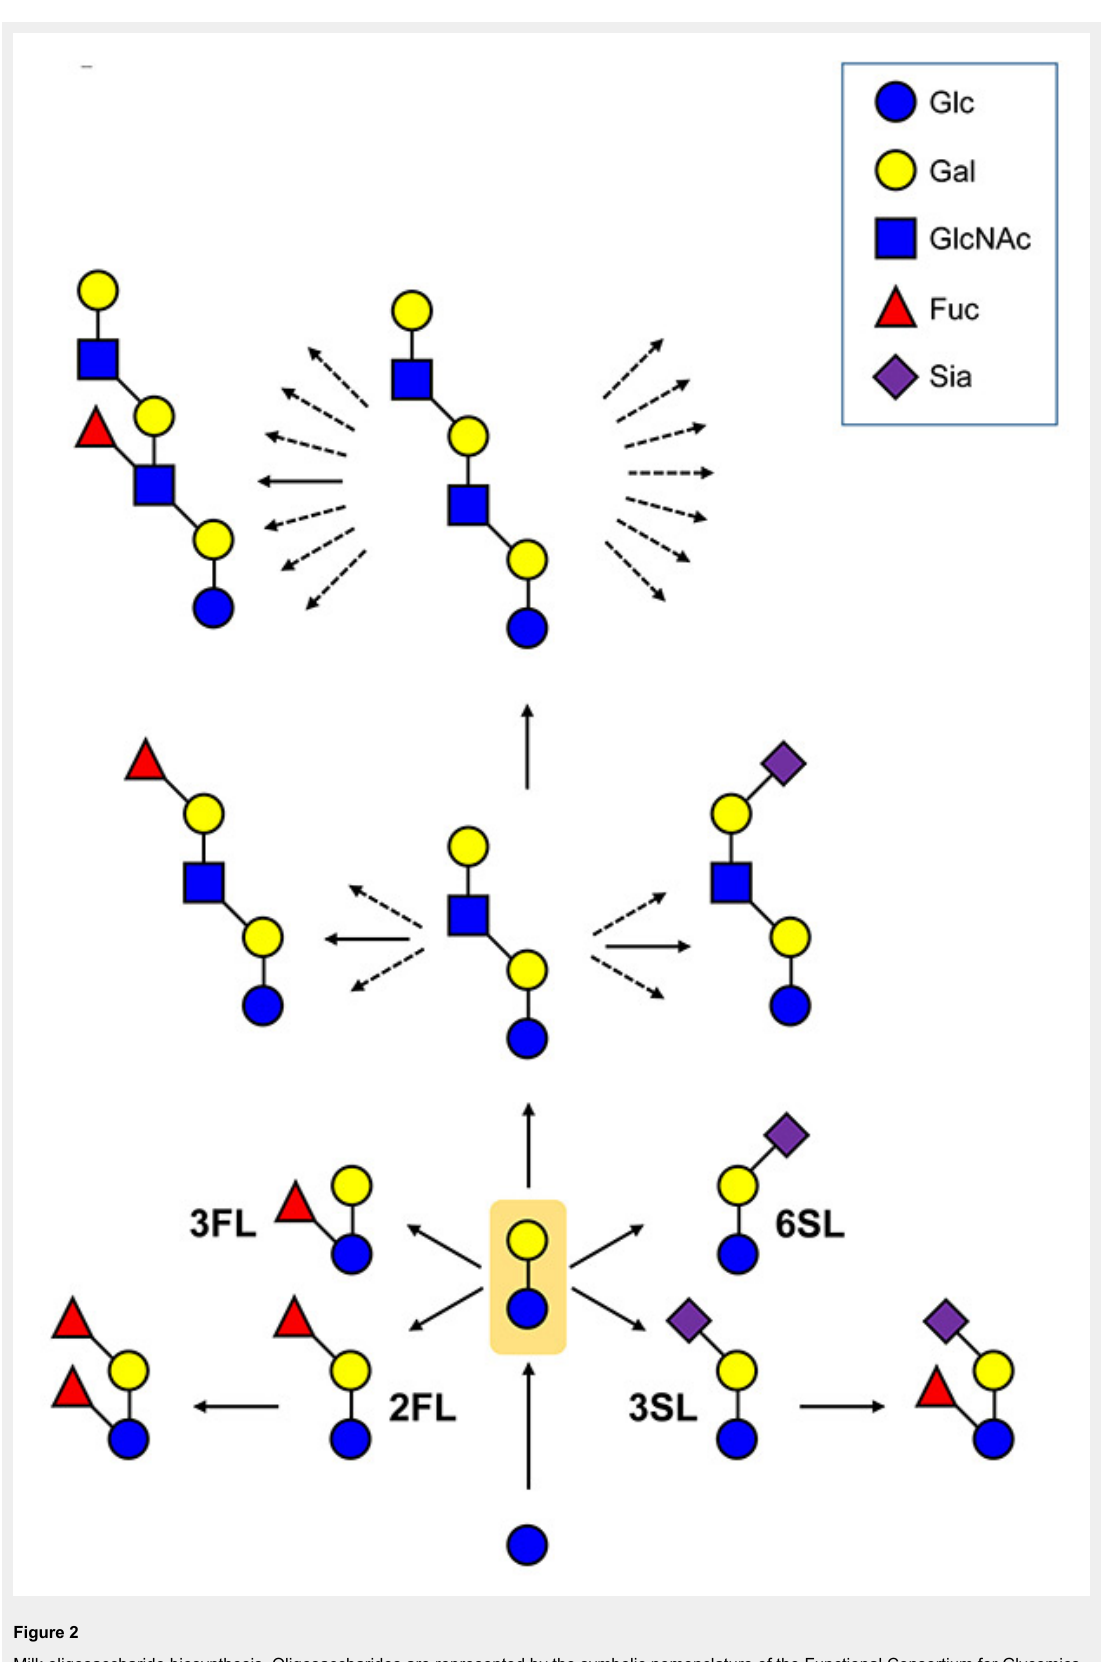
Figure 2 Milk oligosaccharide biosynthesis. Oligosaccharides are represented by the symbolic nomenclature of the Functional Consortium for Glycomics (see www.functionalglycomics.org/static/consortium/Nomenclature.shtml). The disaccharide lactose (in orange frame) is produced by the β1–4 galactosyltransferase / α-lactalbumin complex. Lactose is further modified by elongation with galactose(β1–4)N-acetylglucosamine disaccharides and addition of fucose and sialic acid. 2FL = fucosyl(α1,2)lactose; 3FL = fucosyl(α1,3)lactose; 3SL = sialyl(α2,3)lactose; 6SL =